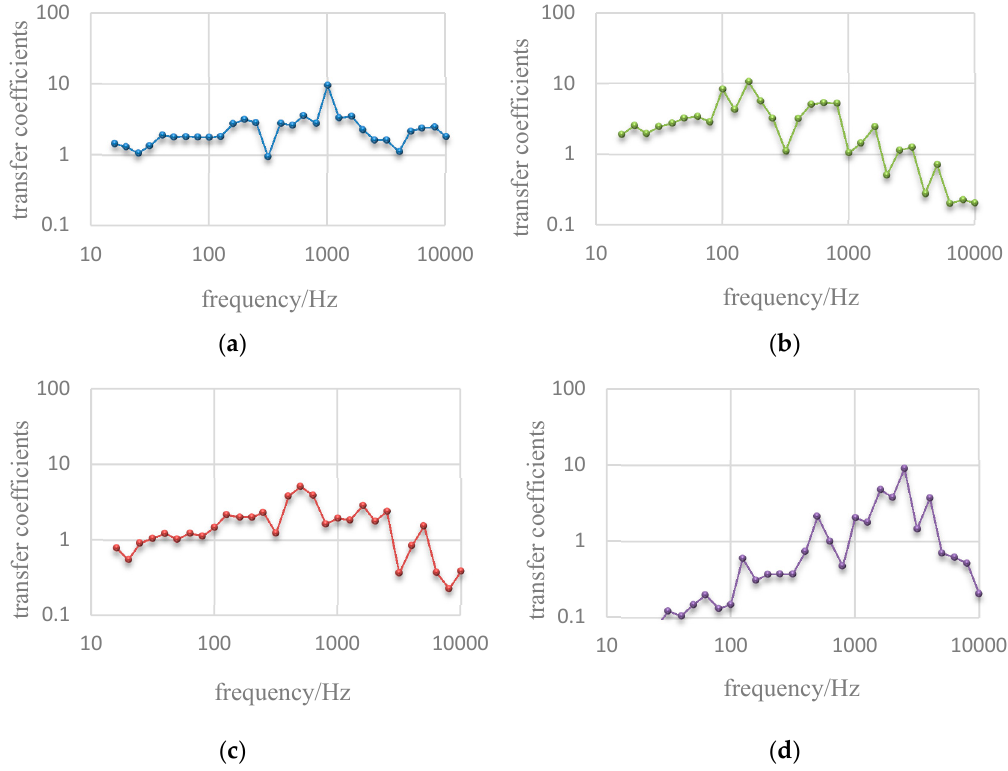
Figure 12. Test results under 2600 r/min: ( a ) SLMB; ( b ) DLMB; ( c ) BCR and ( d ) RP.